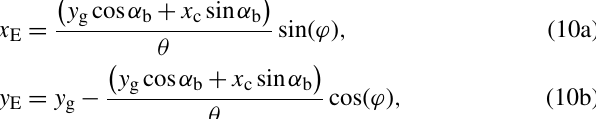
Figure 6. Temporal change in the downdrift control point (C. P.) for applying the parabolic model including the effect of wave diffrac- tion due to oblique waves within a littoral cell, also showing maxi- mum indentation ( × ) at each time